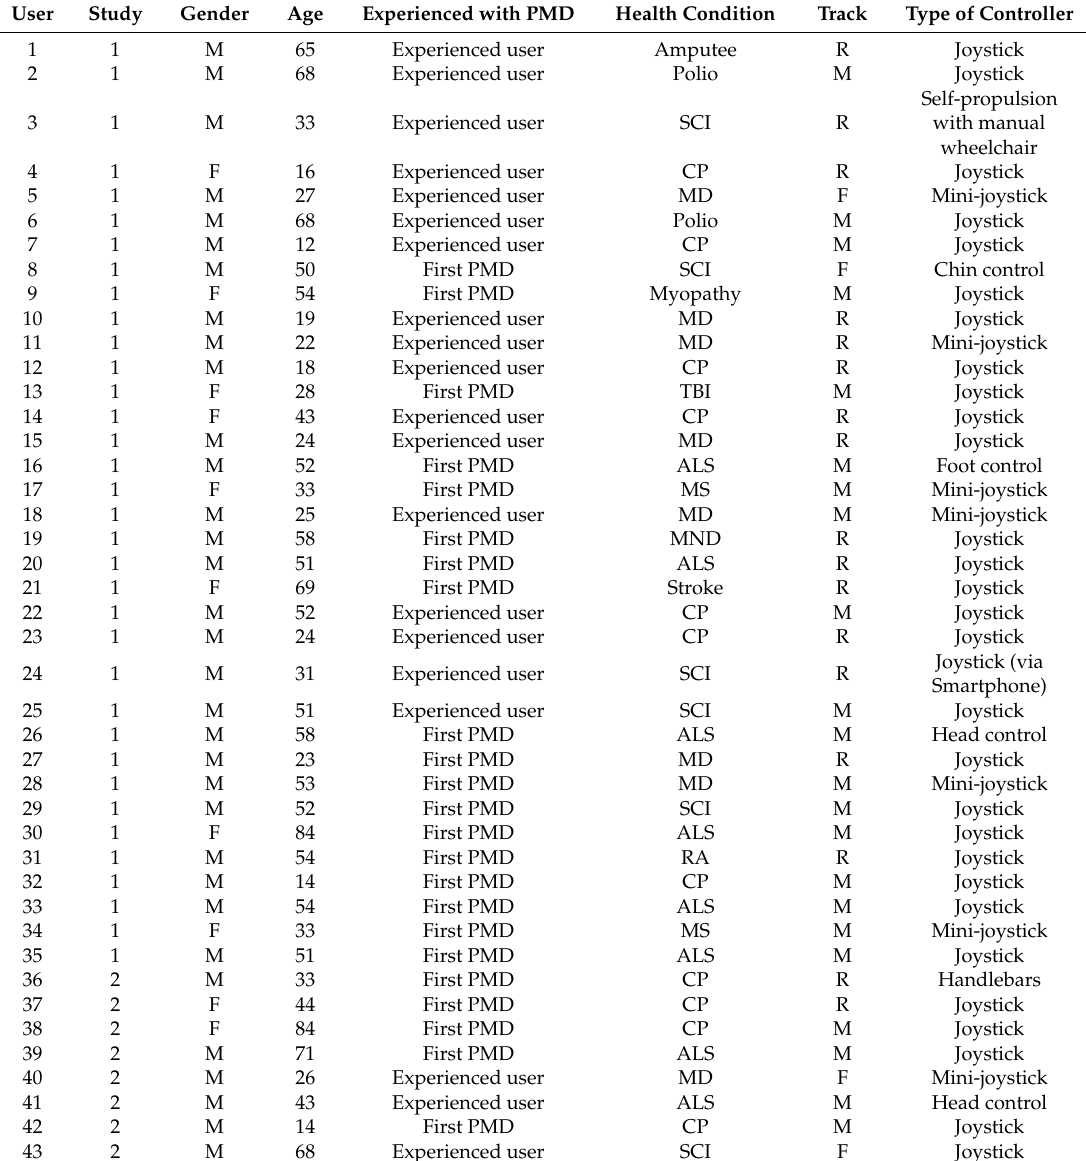
Table 1. Participants’